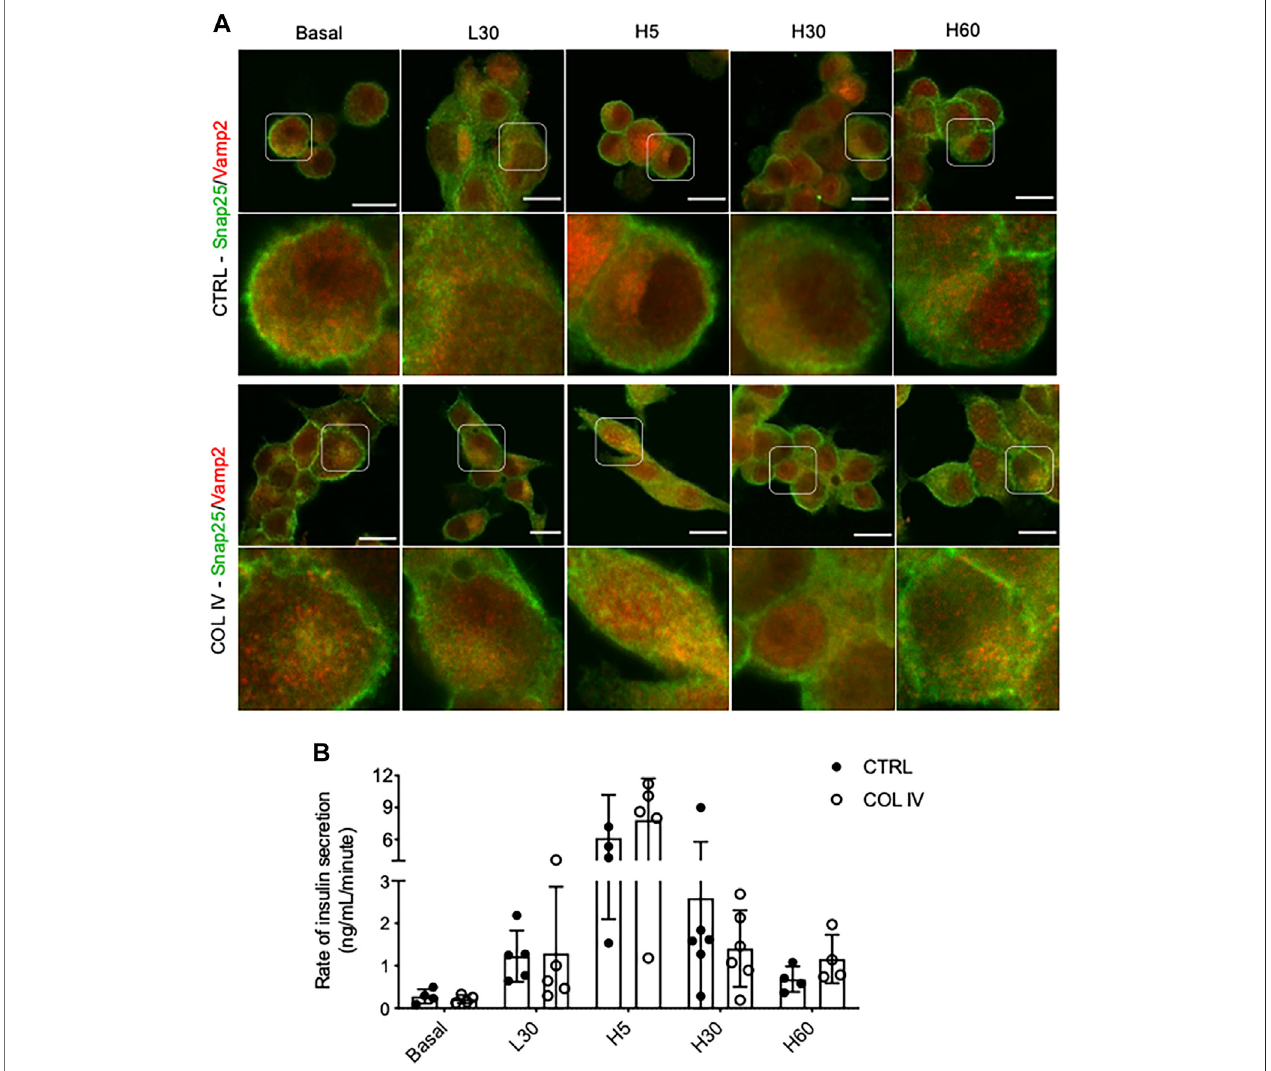
FIGURE 4 | Collagen IV enhances Snap25 and Vamp2 colocalization and rate of insulin secretion during GSIS in INS-1 cells. Representative double immunostaining of (A) Snap25 (green)and Vamp2 (red)in INS-1cells cultured oncollagenIV(COL IV)or BSA-coatedcontrol(CTRL) inbasal,lowglucose (2.2 mmol) for 30 min (L30), high glucose (22 mmol) for 5 min (H5), 30 min (H30), and 60 min (H60). Nuclei are counterstained with DAPI, and magni fi ed images are highlighted. Scale bar: 10 µm. (B) Rate of insulin secretion in each of the treatment conditions. Data are expressed as ng per mL per minute (mean ± SEM; n = 4 – 6 experiments/